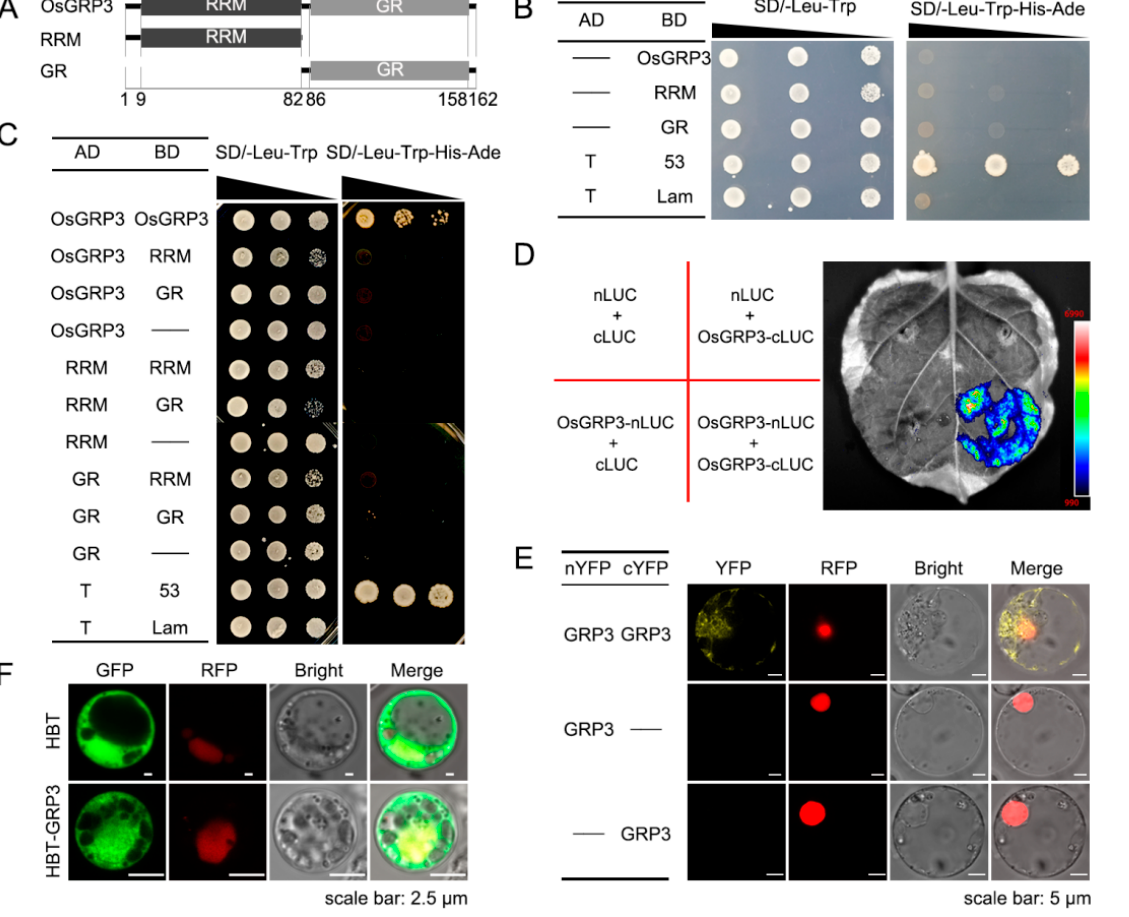
Figure 4. Autoassociation of OsGRP3. ( A ) The OsGRP3 was truncated as two parts RRM and GR according to the number of amino acids shown on the axes. ( B ) Autoactivation test of full length of OsGRP3 and truncated parts, RRM and GR, by yeast two-hybrid assays. “__” indicates empty victor. T and 53 were co-transferred as positive controls, and T and Lam as negative controls. ( C – E ) Autoassociation test of OsGRP3. ( C ) Yeast two-hybrid assays. The annotations in ( C ) are the same as in ( B ). ( D ) Bimolecular luminescence complementation assay. The texts on the left in ( D ) indicate the different combinations of carrier strains injected into the right leaf. ( E ) Bimolecular fluorescence complementation assay. The scale bars indicate 5 μ m. ( F ) Subcellular localization of OsGRP3. The scale bars indicate 2.5 μ m. bZip63-RFP is used as nuclear markers in ( E , F ).